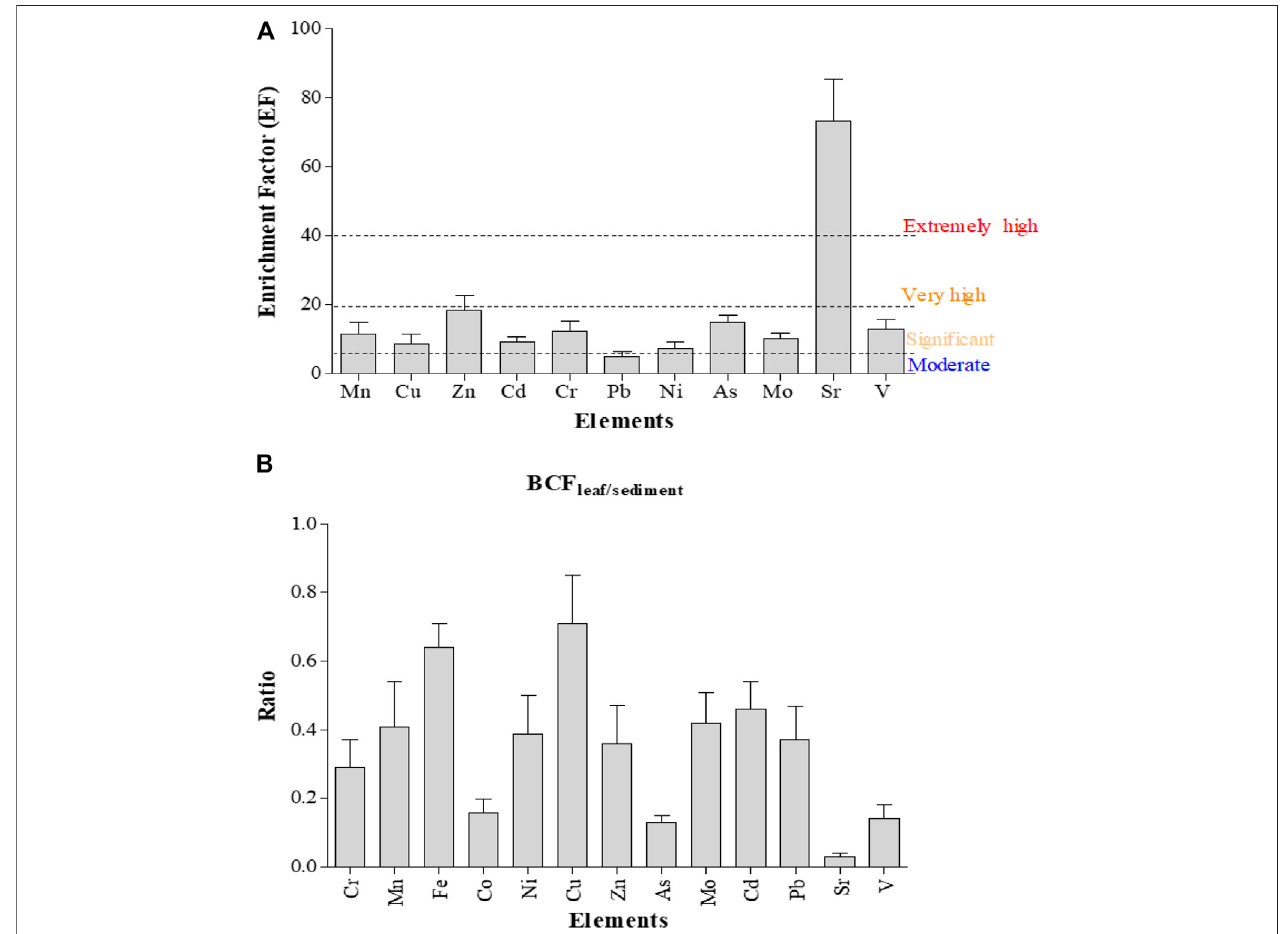
FIGURE 5 | Metal enrichment factor (A) and bioconcentration factor (BCF) for metal concentrations in six mangrove ecosystems (B) .